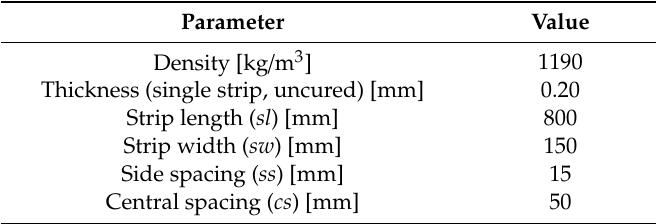
Figure 1. Schematic of the PY panel layout (top view). Table 2. Properties of the SMACWRAP ® strips embedded in the panel.